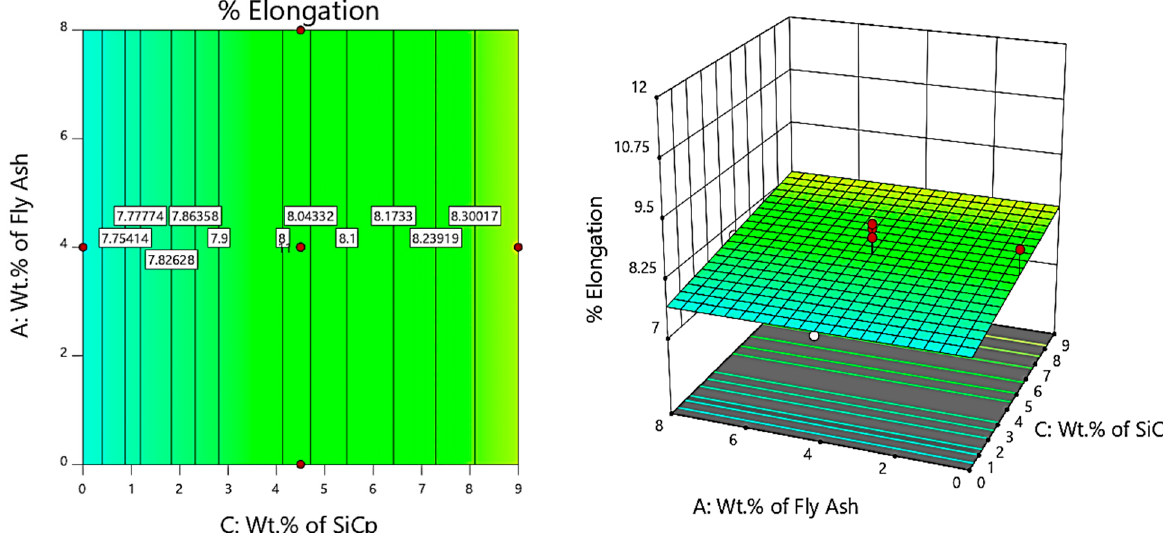
Figure 18. Contour plot for variation of % elongation with varying wt.% of fly ash and SiC.